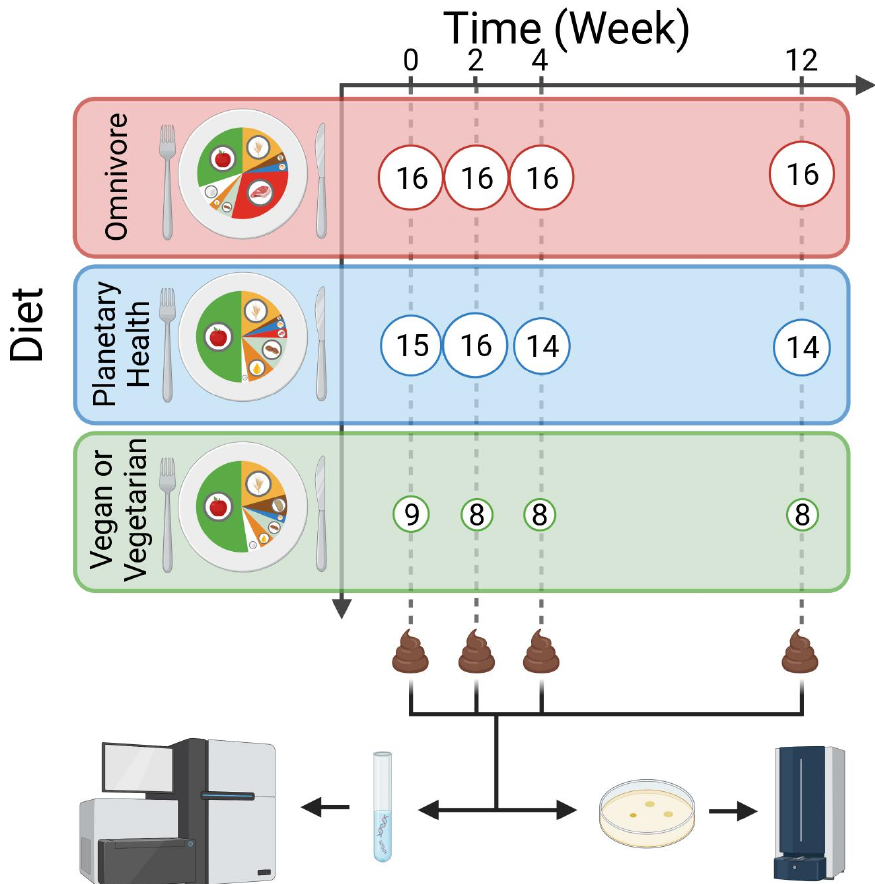
Figure 1. Design of the study. Participants followed three different diets over the course of twelve weeks. Stool was sampled at different time points and whole metagenome sequencing was performed. Additionally, bacteria were cultivated on different agar plates and analysed with MALDI-TOF mass spectrometry. Numbers in white circles depict the numbers of participants and respective stool samples at the different time points for each group.